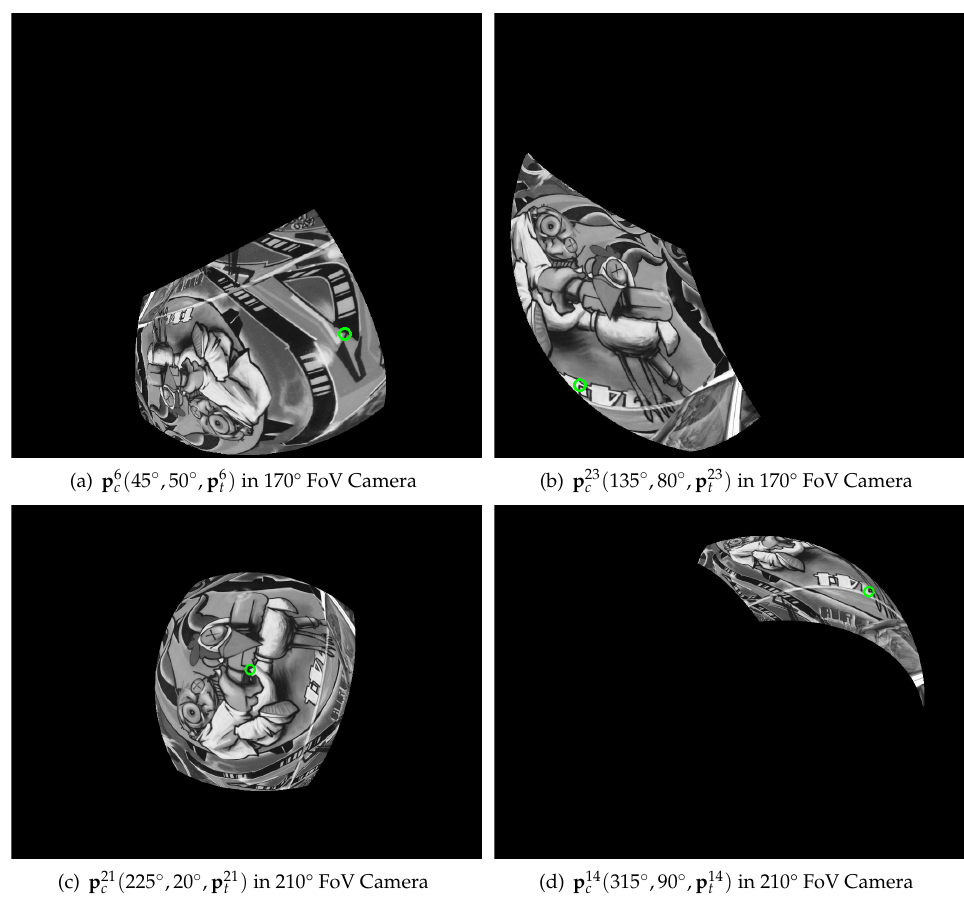
Figure A4. Some examples of virtual dataset test sample. The green circle in sample image indicates the feature